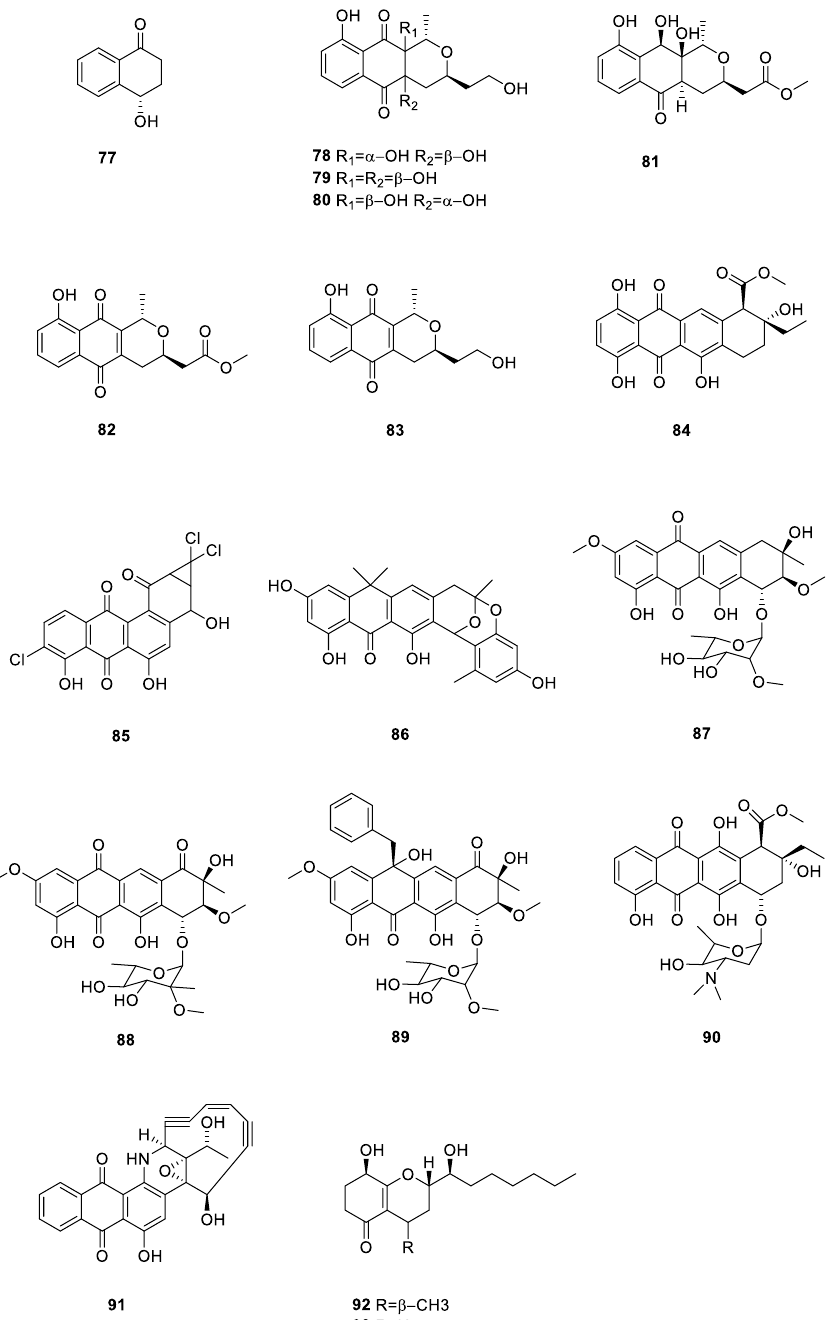
Figure 10. Chemical structures of compounds 77 − 93 from lichen-associated actinomycetota.